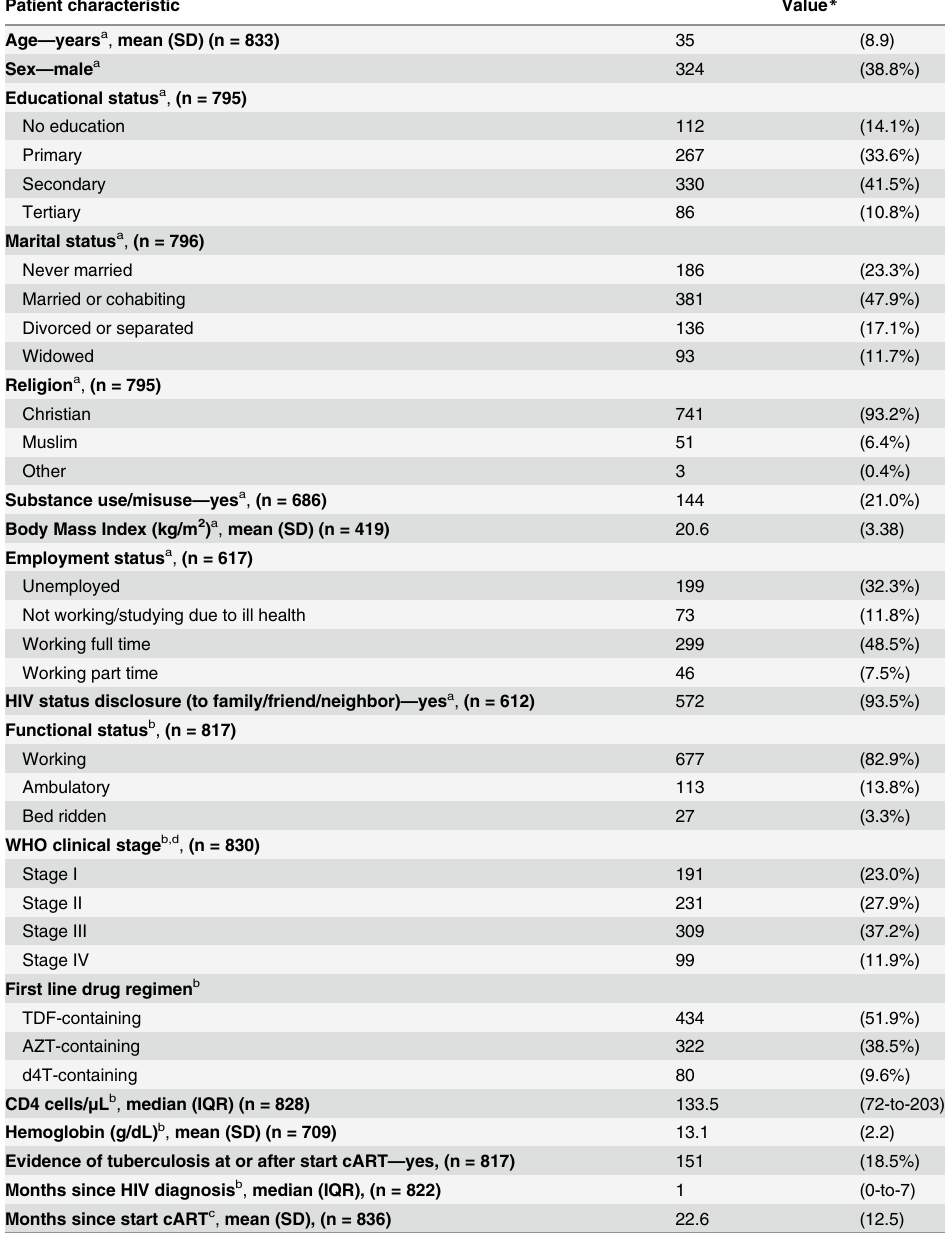
Table 1. Patients ’ socio-demographic, clinical, and treatment characteristics (n =